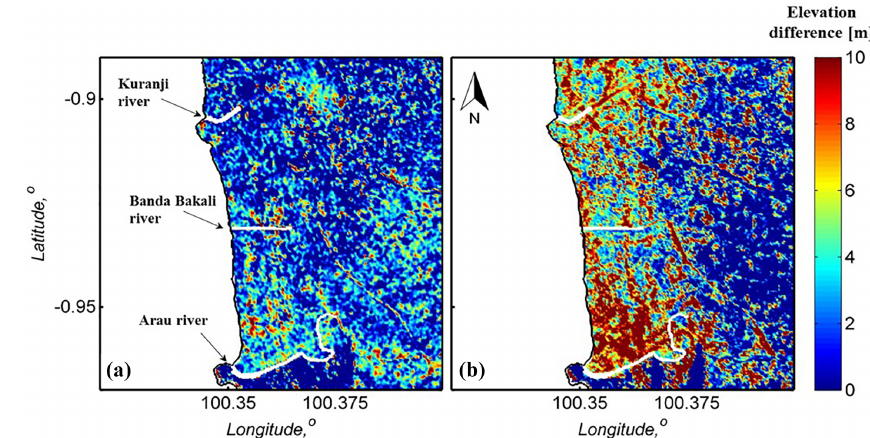
Figure 5. Elevation differences of global DEM datasets with respect to DEM5: (a) SRTM1 and (b) GDEM2. Table 2. Tsunami evacuation shelters in